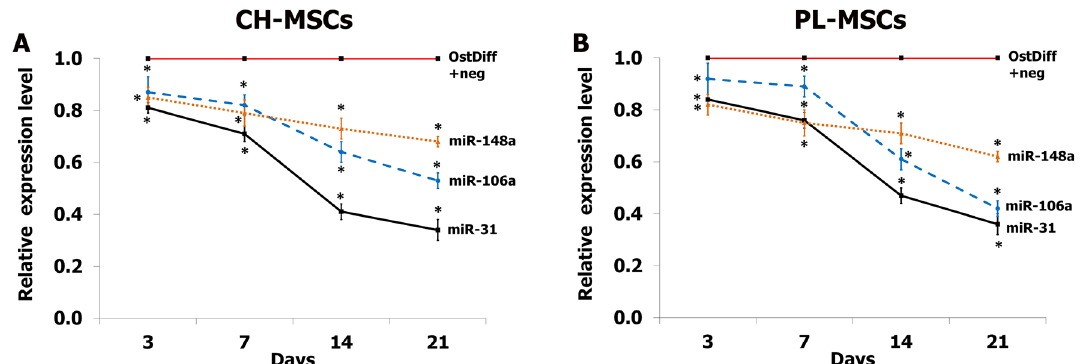
Figure 7. The expression of miR-31, miR-106a, miR-148a in CH-MSCs ( A ) and PL-MSCs ( B ) treated with anti- miR-31, anti-miR-106a, and anti-miR-148a at days 3, 7, 14, and 21. MSCs cultured in osteogenic differentiation medium supplemented with miRNA negative control (OstDiff+Neg) were used as a control. OstDiff+Neg of each time point was used to normalize the data at each individual time